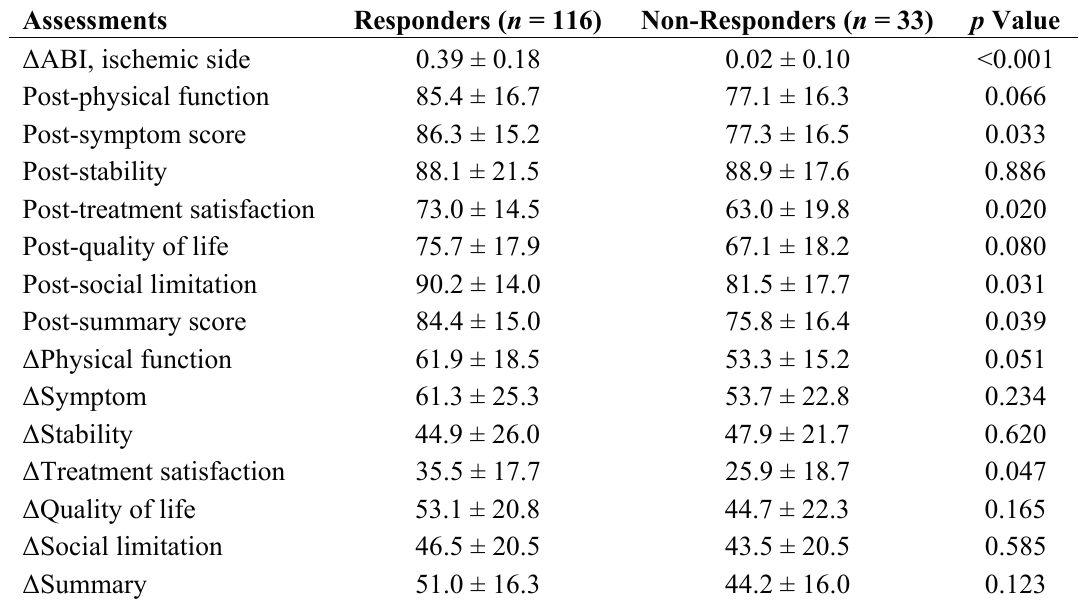
Table 5. Comparison of PAQ scores and ABI between responders and